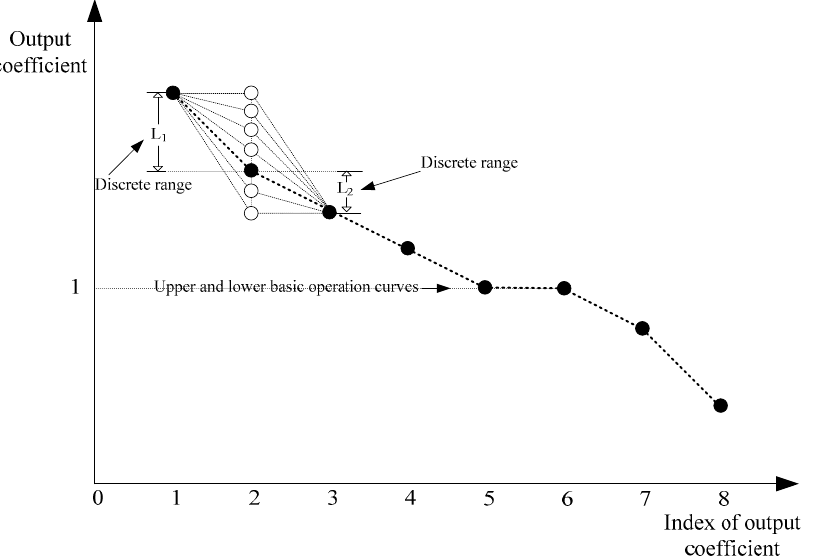
Figure 3. Sketch Map of operation curves optimization by Progressive Optimality Algorithm (POA).